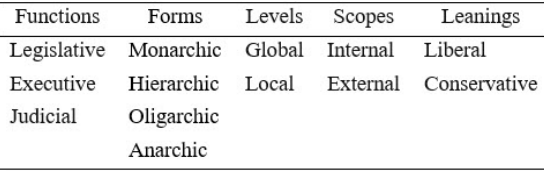
Table 1. Summary of TSs with the five thinking